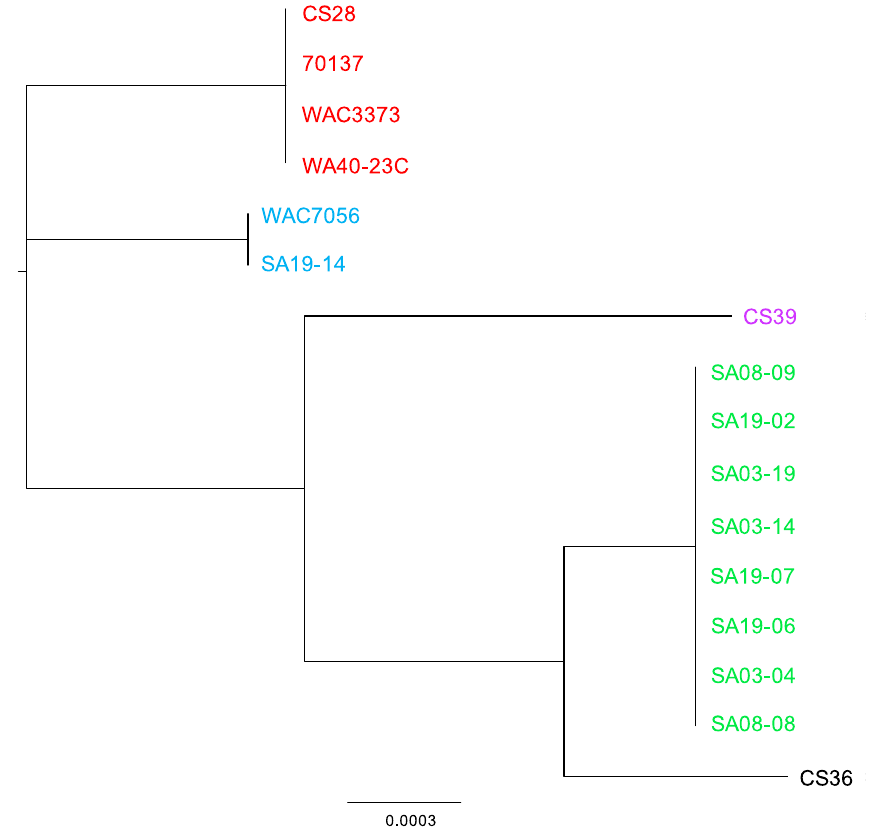
Figure 6. Phylogenetic analysis using PhyloSift. PhyloSift was used to analyze R. toxicus genomes, based on default parameters (maximum ‐ likelihood analysis). The output tree file was input into FigTree v1.4.3 (tree.bio.ed.ac.uk/software/figtree/) to produce the phylogenetic tree. Strains within the phylogenetic tree are color ‐ coded based on the genetic population. Green: RT ‐ I; blue: RT ‐ II; red: RT ‐ III; black: RT ‐ IV; purple: RT ‐ V.